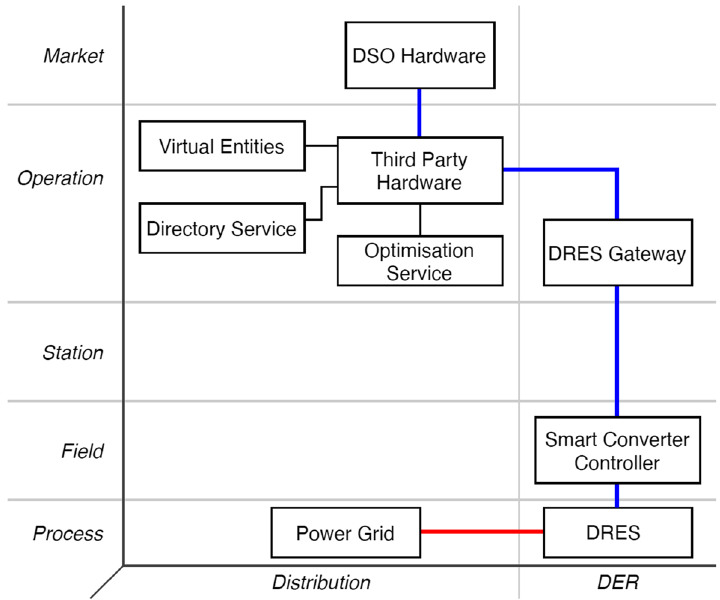
Fig. 3 Component layer of the proposed